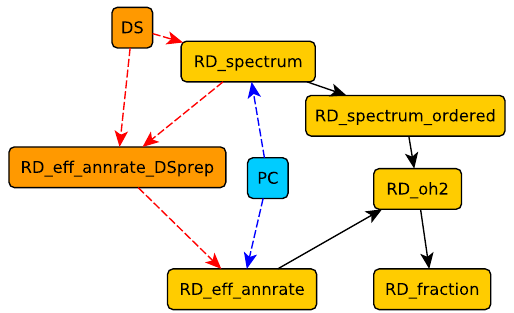
Fig. 2 Relic density overview plot. The capabilities required for relic density calculations are the effective annihilation rate W eff and the ordered spectrum of coannihilatingparticles.Currently, thesequantities can be set up either directly with DarkSUSY (DS) or in simpler cases without coannihilation via the Process Catalogue (PC). However, each of these functions can be easily replaced with a user-defined